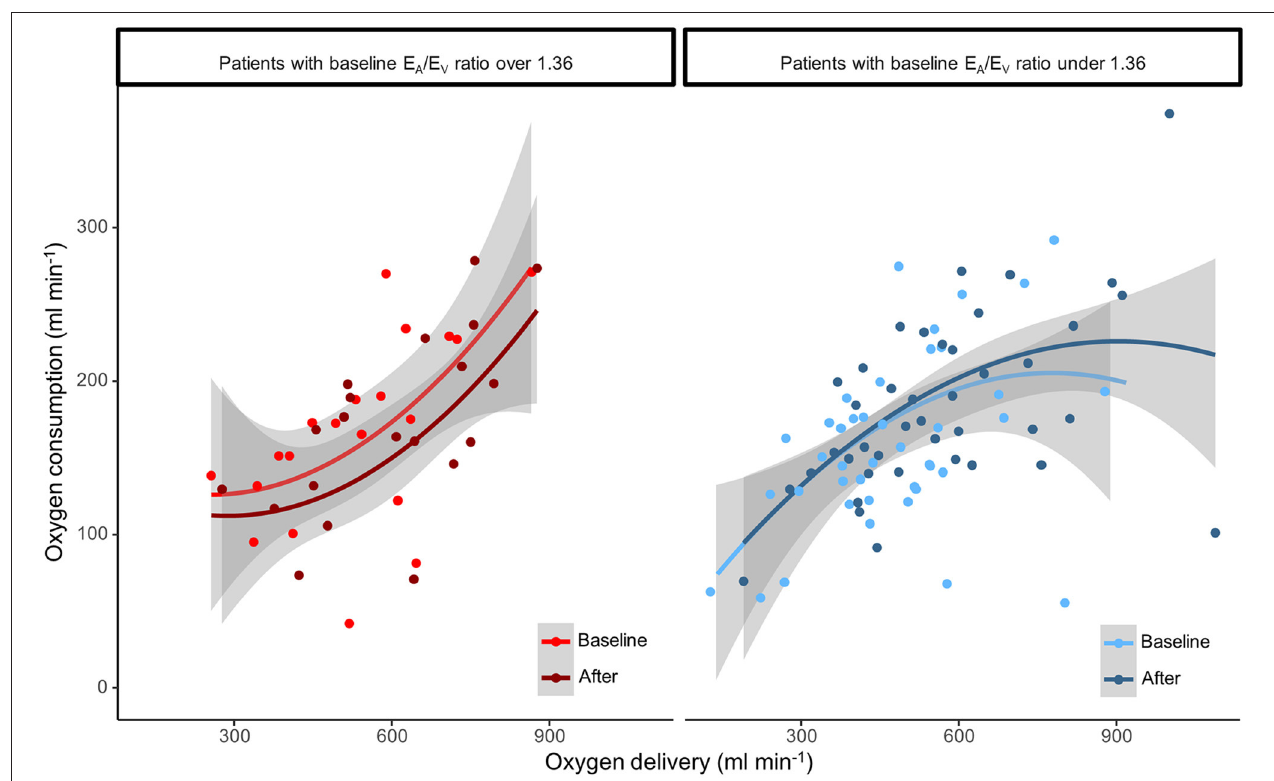
FIGURE 1 | Relationship between oxygen delivery (DO 2 ) and oxygen consumption (VO 2 ) in uncoupled and coupled patients before and after the hemodynamic